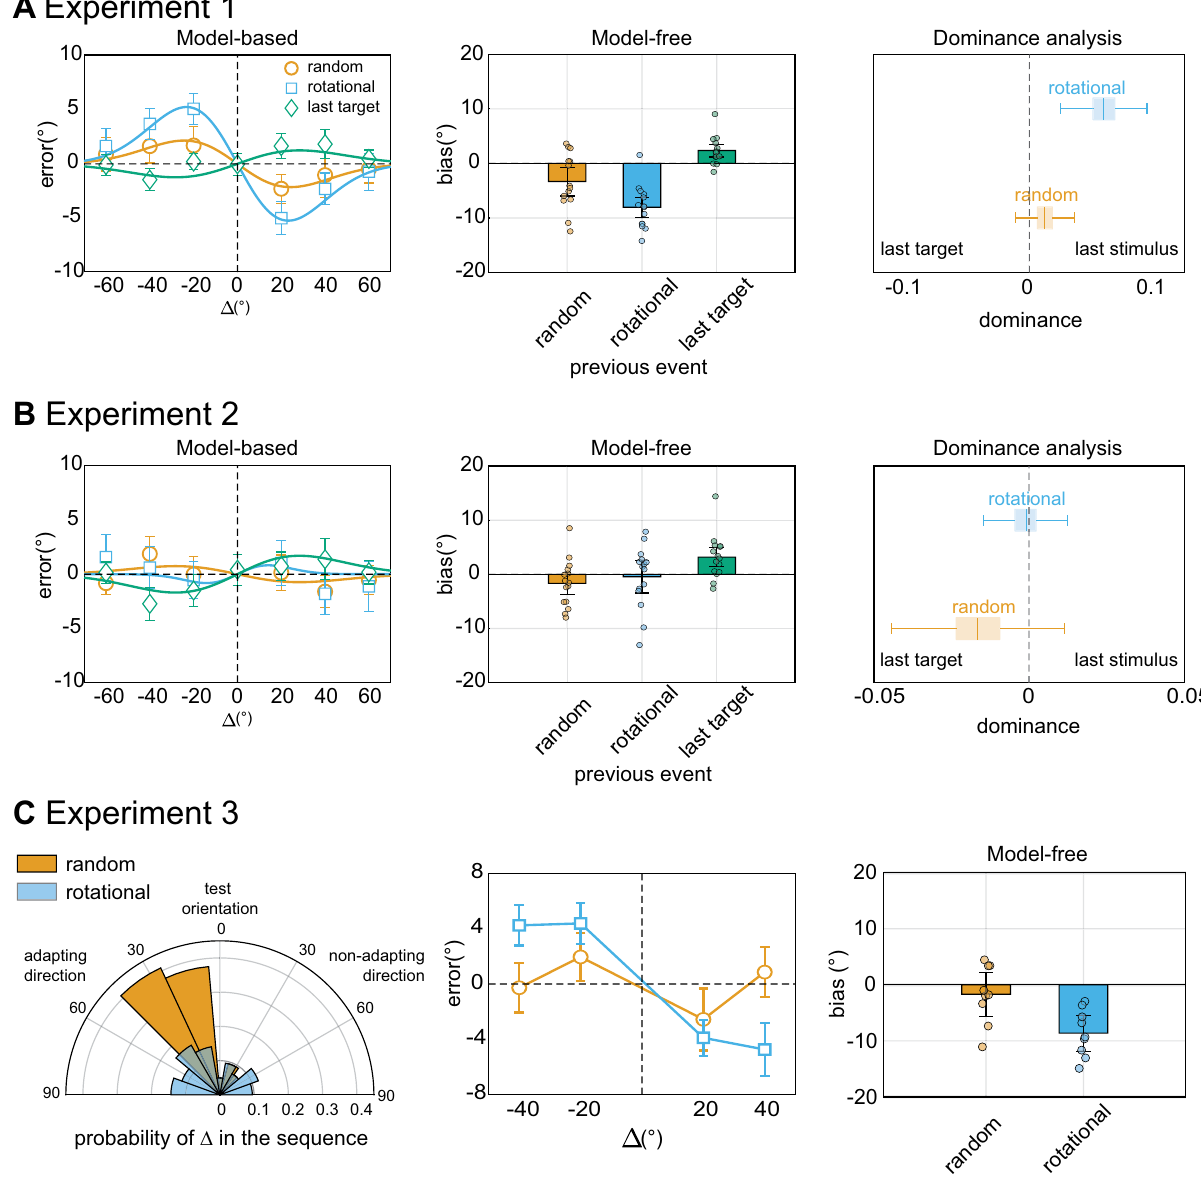
Figure 2. ( A ) Results for model-based, model-free, and dominance analyses of Experiment 1. Repulsive adaptation followed random sequences of sensory signals (orange circles, curves, and bar). The presence of rotational structures pushed perceptual reports further away from previous stimuli and toward future states (sky blue circles, curve, and bar). Previously reported orientations (last target) had the opposite effect, inducing serial dependence toward the past (green diamonds, curve, and bar). The bias induced by rotational sequences dominated perceptual reports (boxplots on the right side). ( B ) Results of Experiment 2. Presenting stimuli at different retinal locations removed both adaptation and RM effects, while SD by previous targets remained significant. In this experiment, the bias toward the past dominated, particularly during random sequences of stimuli (boxplots on the right side). ( C ) Results of Experiment 3. The polar plot on the left shows the proportion of adaptors shown in this experiment, to induce more adaptation bias in the Random compared to the Rotational condition. The central plot shows the average error over Δ in the two conditions (mean-corrected per condition), revealing larger repulsive biases for rotational than for random sequences, despite the designed asymmetry in adaptation bias. The use of noisy and low-contrast Gabors removed overall adaptation effects whereas momentum effects remained significant (model-free results, bar plot on the right side). Error bars are standard errors of the mean in line plots and 95% CI of the mean in bar